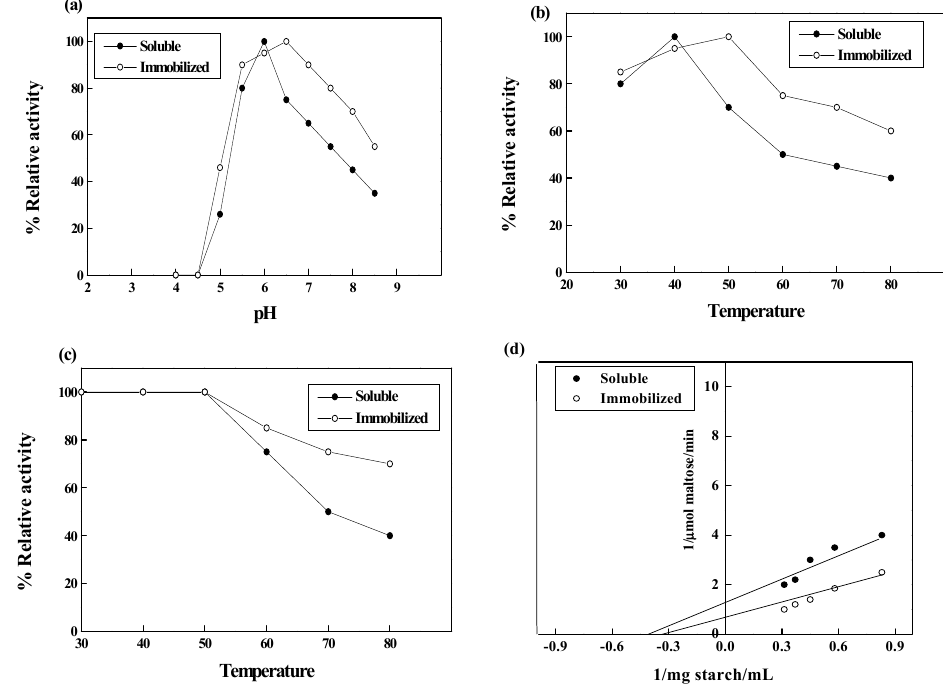
Figure 5. Optimum pH ( a ), optimum temperature ( b ), thermal stability ( c ) and Km ( d ) of soluble and immobilized α -amylases. Each point represents the average of two